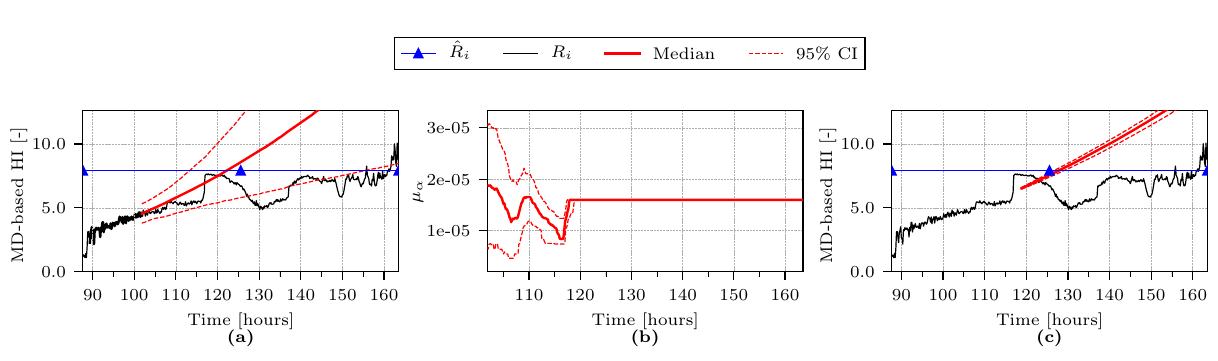
Figure 13: R and initial median and 95% CI output of the corresponding PF. (a) R 1 optimization input, blue line for FT, and red lines for median and 95% CI of PF; (b) α over time for the initiated PF; (c) predicted PF trend when µ